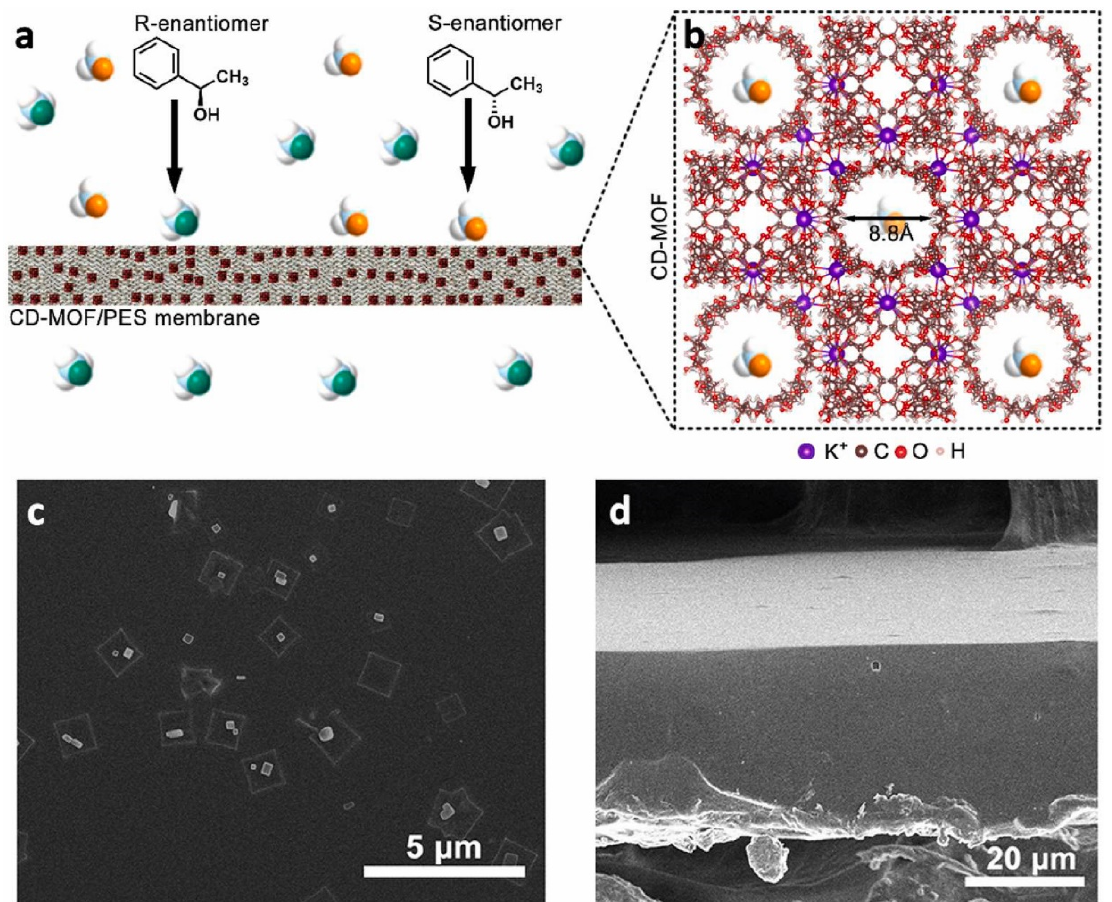
Figure 3. Schematic illustration and SEM images of γ–cyclodextrins–based metal–organic frame- Schematic illustration and SEM images of γ –cyclodextrins–based metal–organic frameworks (CD– works (CD–MOF)/polyethersulfone mixed matrix membranes and ( a ) CD–MOF/PES MMM for MOF)/polyethersulfone mixed matrix membranes and ( a ) CD–MOF/PES MMM for selective transport of R–(+)–1– selective transport of R–(+)–1–phenylethanol molecules from racemic mixture. ( b ) 3D structure of phenylethanol molecules from racemic mixture. ( b ) 3D structure of CD–MOF. ( c ) SEM image of CD–MOF/PES MMM CD–MOF. ( c ) SEM image of CD–MOF/PES MMM surface and ( d ) cross–section . Reprinted with surface and ( d ) cross–section. Reprinted with permission from [42] Copyright 2021 Membrane permission from [42] Copyright 2021 Membrane Science.